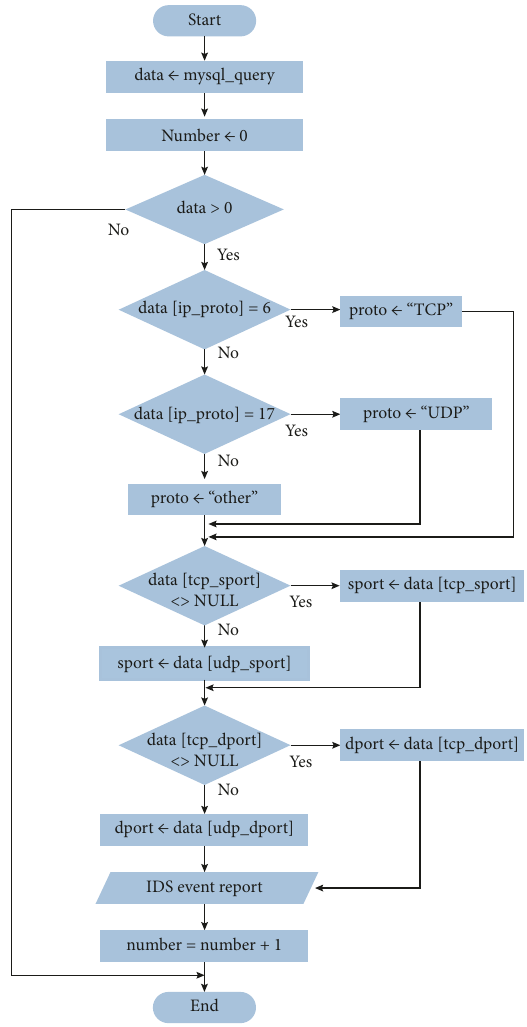
Figure 6: Flowchart of the sorting process.